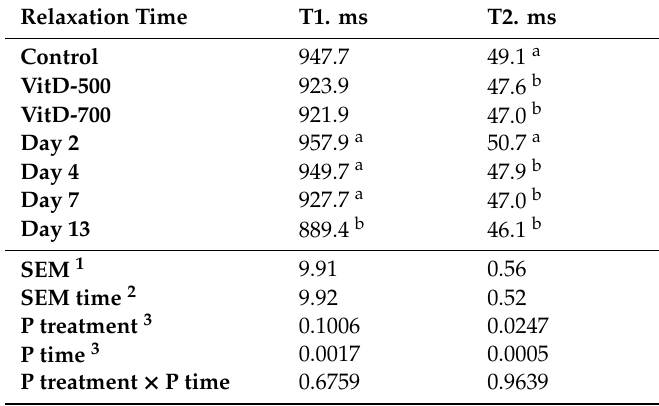
Table 7. Mean values of the spin-net or longitudinal relaxation time (T1) and the spin-spin or transverse relaxation time (T2) from pigs supplemented with vitamin D 3 in water at di ff erent doses (500,000 IU / L vs. 700,000 IU / L) or without supplementation prior to slaughter (experiment